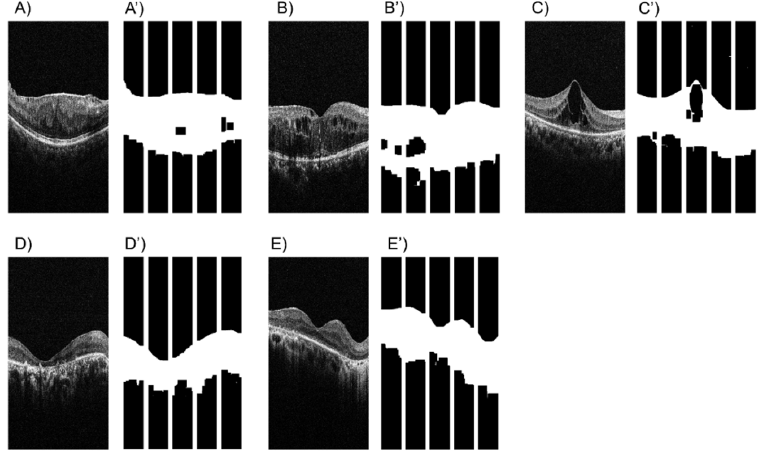
Figure 11. Original ( A – E ) and post-processing ( A (cid:48) – E (cid:48) ) OCT images misjudged by the ML model. The ML model misinterpreted epiretinal membrane ( A ), macular edema ( B , C ), and retinitis pigmentosa ( D , E ). In the OCT images of the epiretinal membrane and macular edema, the inner retinal layer was not filled in with white by morphological transformation. The OCT images of retinitis pigmentosa indicate small retinal and choroidal areas. Abbreviations: OCT, optical coherence tomography; ML, machine learning.